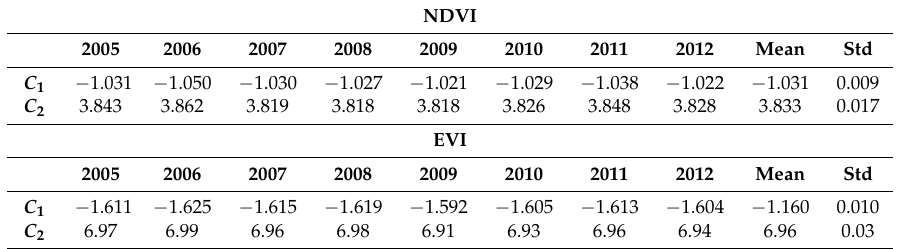
Table 2. Regression coefficients C 1 and C 2 (in kg · m − 2 · yr − 1 ) for each iteration and their final values and errors. For each year, each coefficient has been obtained using the rest of the years. Results are shown for NDVI and EVI.